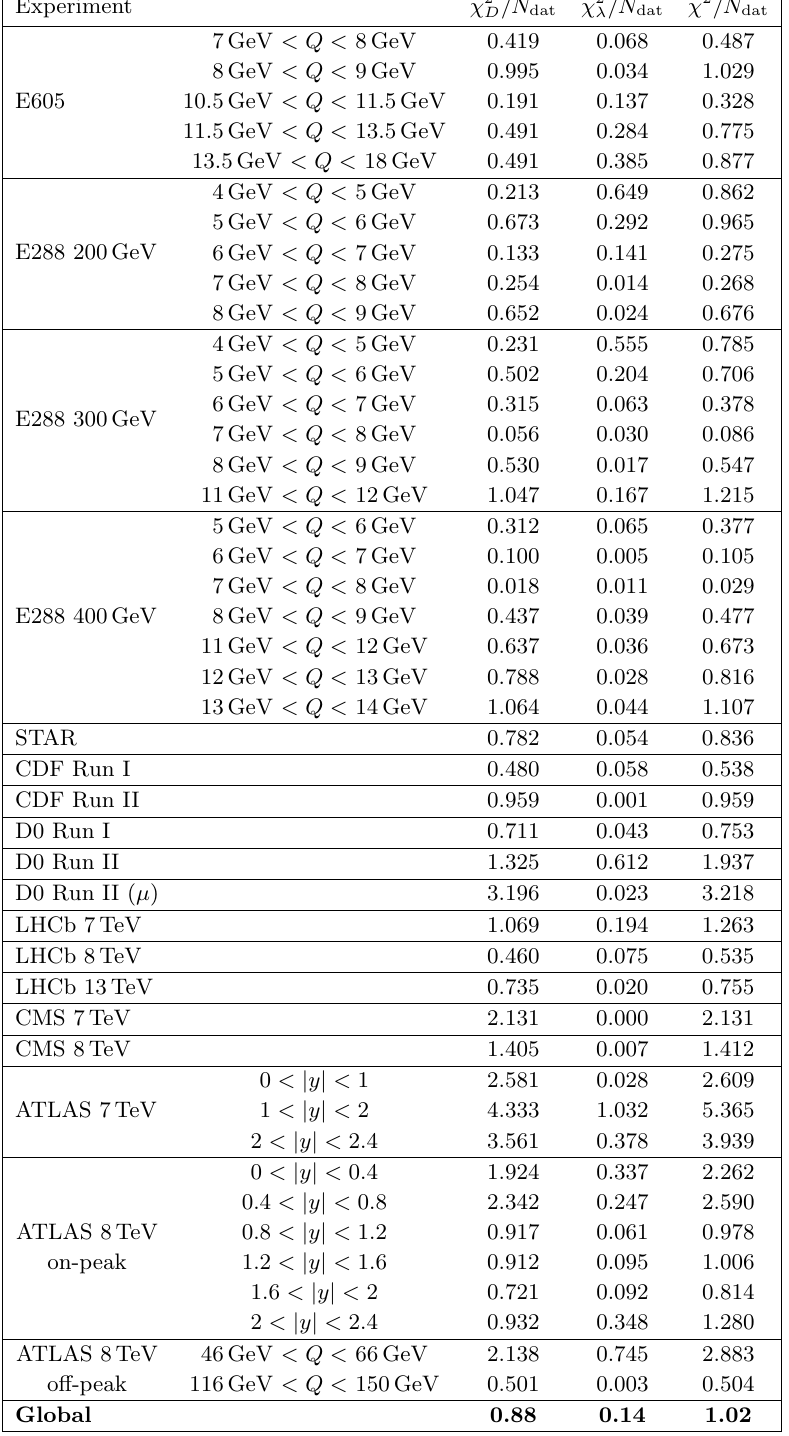
Table 4 . The (cid:31) 2 =N dat using the mean replica in eq. (4.1). N dat in each case is listed in table 2. The uncorrelated ( (cid:31) 2 ) and correlated ( (cid:31) 2 ) contributions and their sum (cid:31) 2 are shown (see eq. D (cid:21)